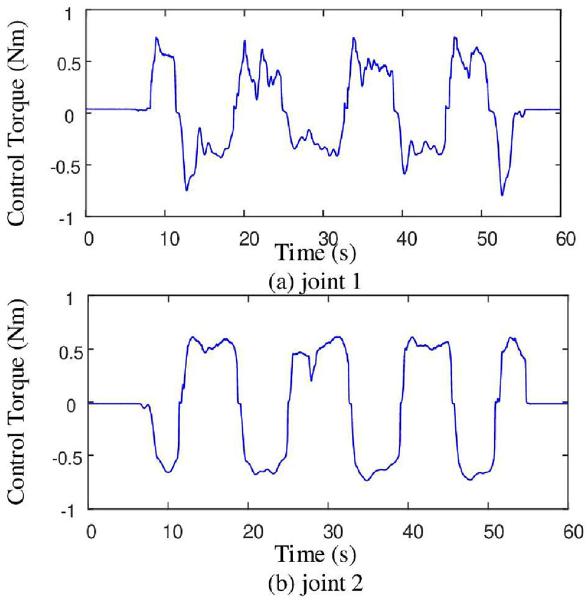
Fig. 15 Control torque curves under proposed decentralized robust interaction control method